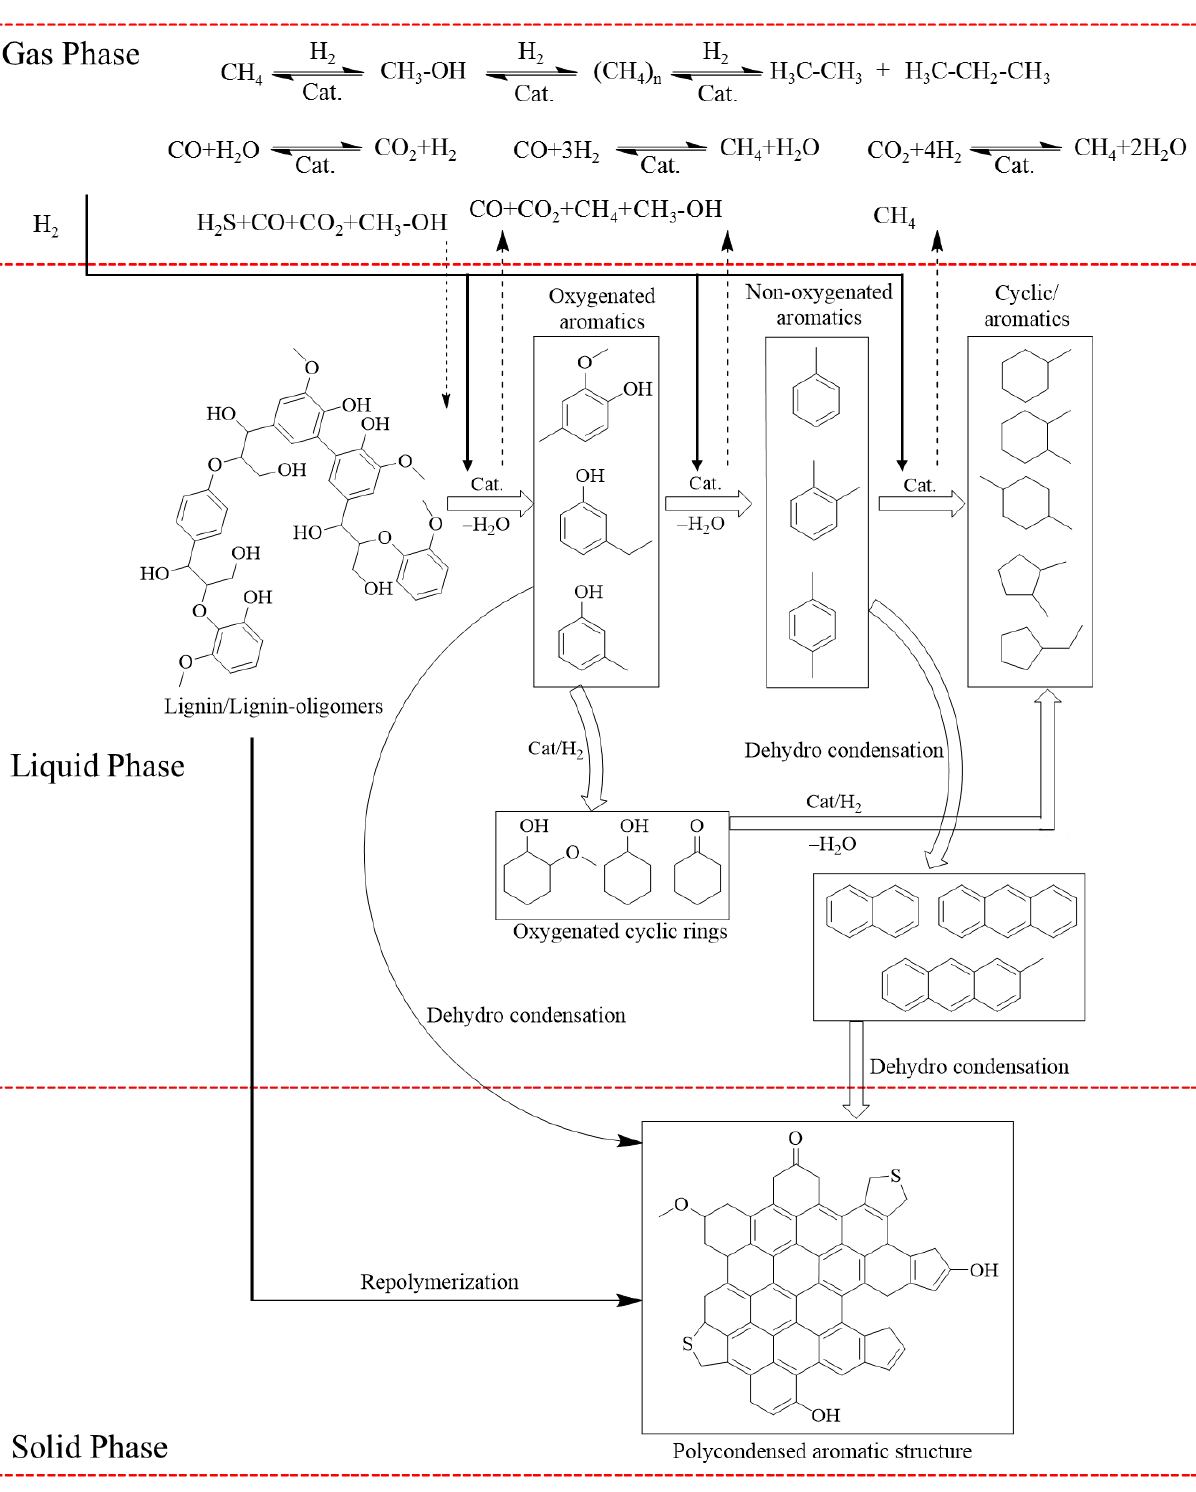
Figure 4. Catalytic hydropyrolysis of lignin.